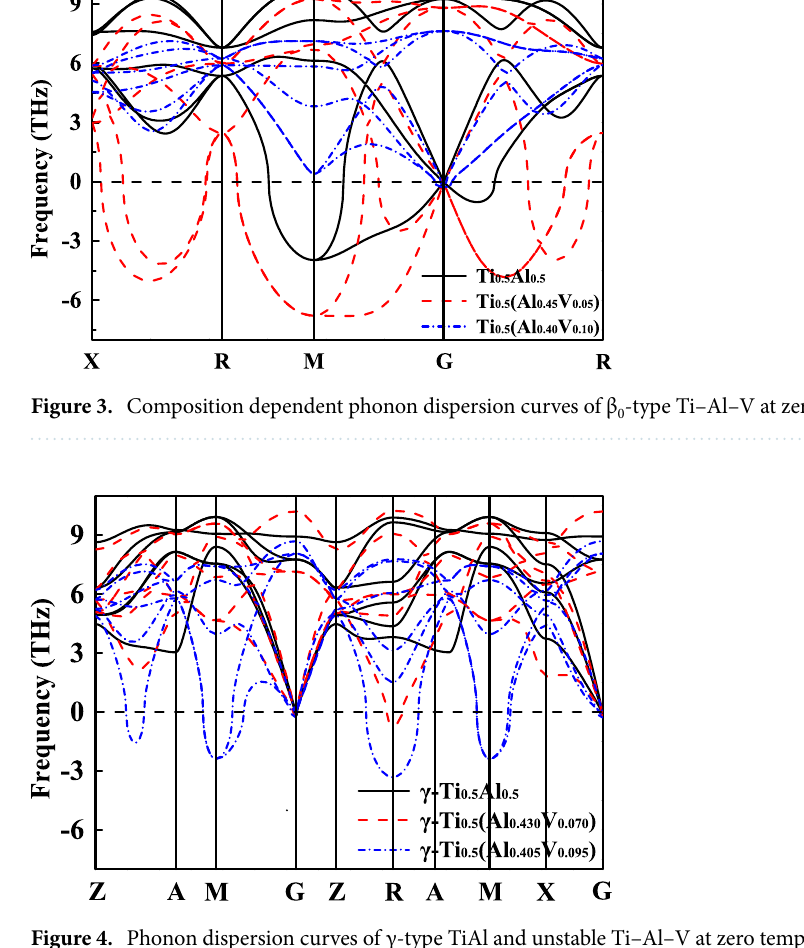
Figure 4. Phonon dispersion curves of γ-type TiAl and unstable Ti–Al–V at zero